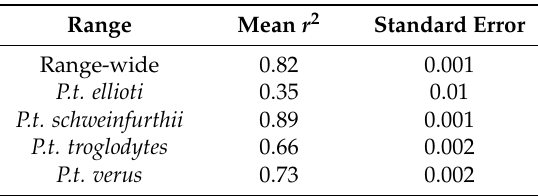
Table 2. Cross-validated mean correlation coefficients with standard errors ( N = 50 cross validations) reported for the entire chimpanzee range, as well as for each sub-species.